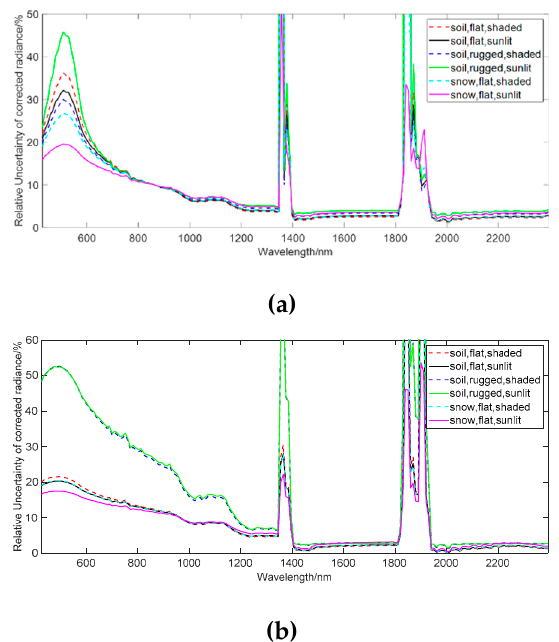
Figure 14. The relative uncertainties of the six verification points after ( a ) C correction; ( b ) Minnaert correction. In each subplot, the six points are respectively the pink dashed line (point 1), the black solid line (point 2), the blue dashed line (point 3), the green solid line (point 4), the cyan dashed line (point 5), and the pink solid line (point 5).